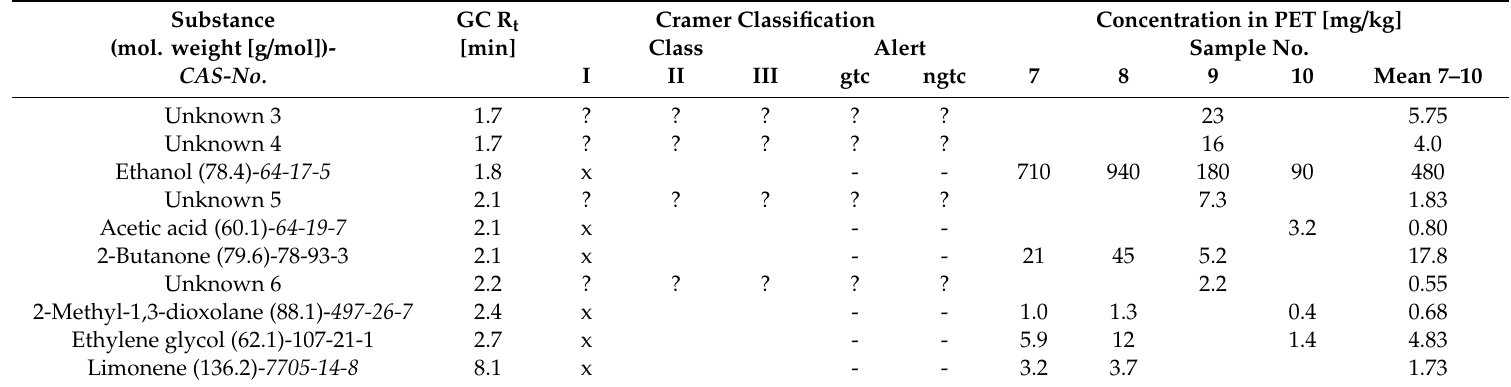
Table 2. Substances found in PET bottles originally used for antifreeze and dishwashing products.